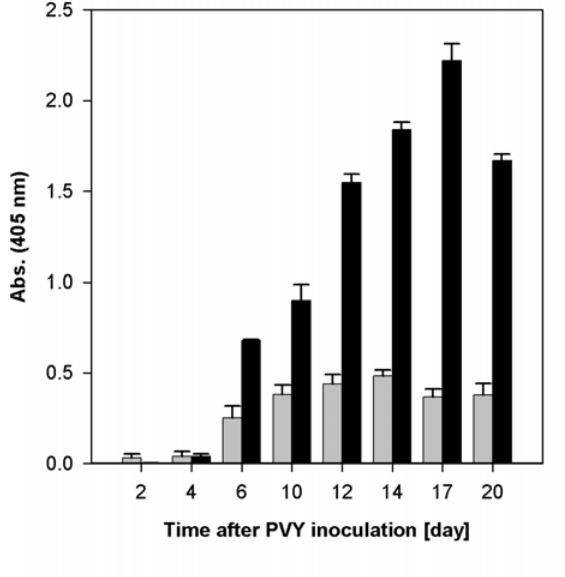
Figure 1. The relative content of PVY O (grey columns) and PVY NTN (black columns) in leaves of Nicotiana tabacum L. in the course of infection. The relative virus content was determined by DAS-ELISA with p -nitrophenylphosphate as substrate for alkaline phosphatase. Absorbance at 405 nm is proportional to the virus content. The absorbance of each sample was measured in triplicate, S.D. are